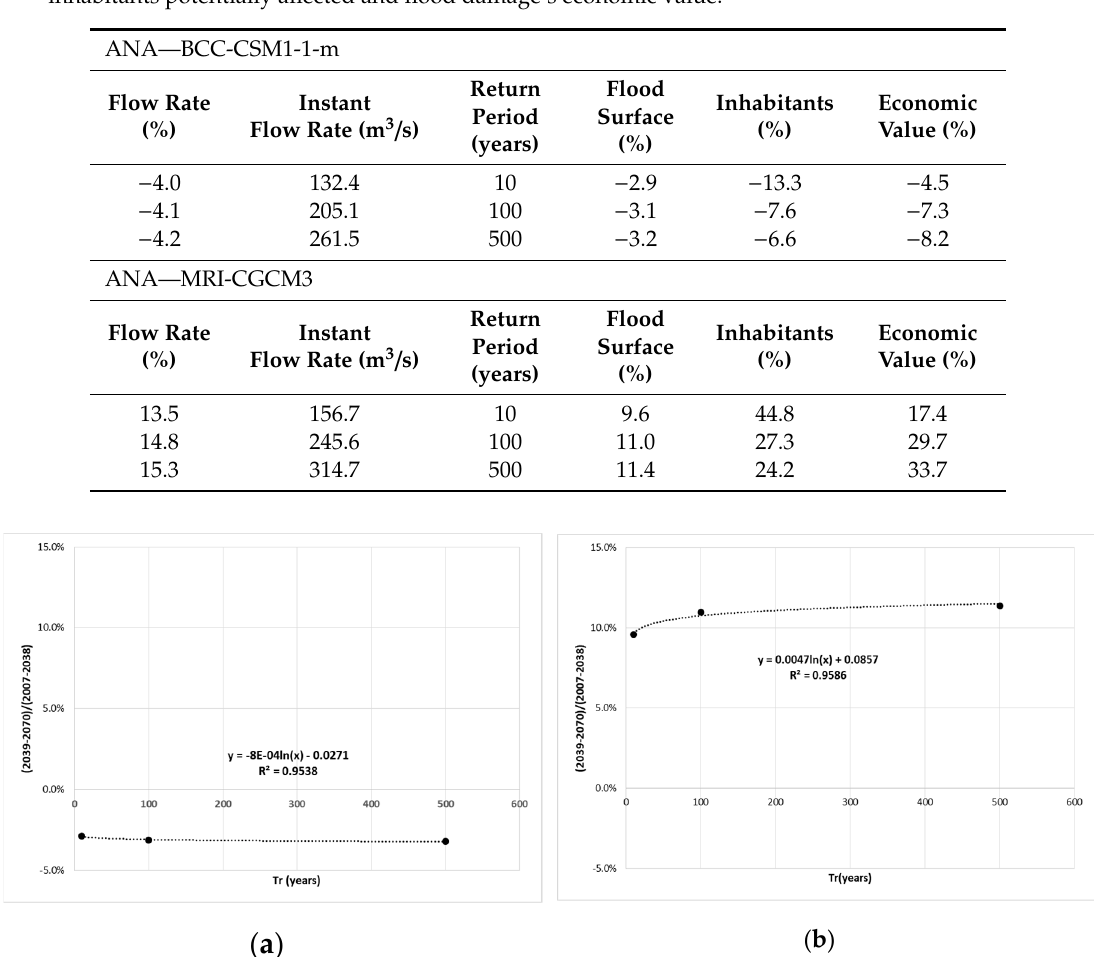
Table 3. Projection ratio 2nd Stage (2039–2070) / 1st Stage (2007–2038) for the flow rate, flood surface, inhabitants potentially a ff ected and flood damage’s economic value.